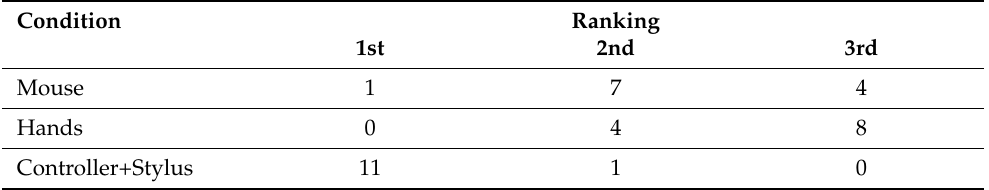
Table 1. The number of mentions of different rankings of the interaction methods when asked for the most liked (1st), the second most liked (2nd), and the least liked (3rd) method. Condition Ranking 1st 2nd 3rd Mouse